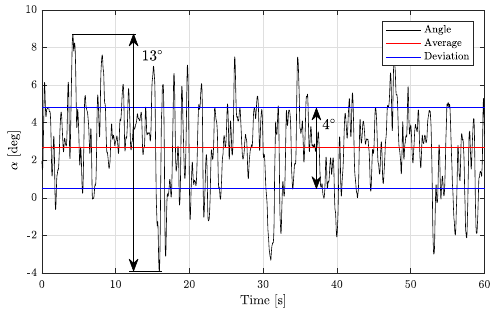
Figure 5. Time history of angle α indicated in Fig. 4